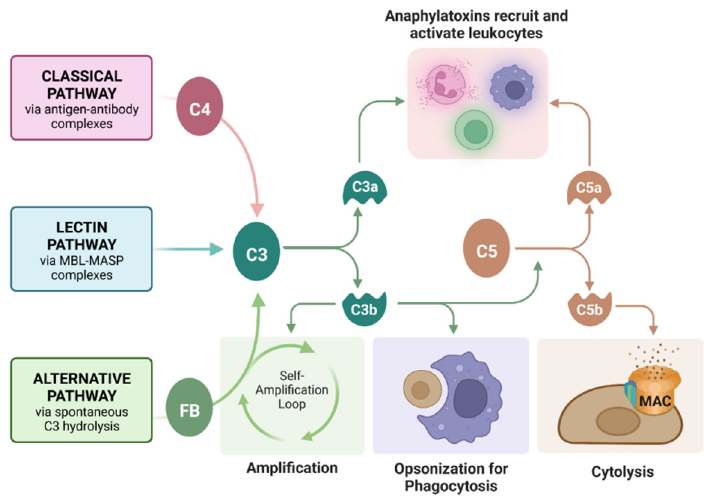
Figure 1. Roles of the complement cascade in graft rejection. Complement can be activated by antibody-bound-antigens recruiting C4 (classical pathway), mannose-binding lectin (MBL)-MBL serine protease (MASP) complexes (lectin pathway, not commonly implemented in graft rejection), or spontaneously by C3 hydrolysis and Factor B (FB) recruitment (alternative pathway). All three pathways converge on the cleavage of C3, which feeds back into the alternative pathway for amplification, opsonizes the grafted cells for phagocytosis, or cleaves C5 to form the membrane attack complex (MAC, C5bC6C7C8C9), causing cell lysis. Anaphylatoxins C3a and C5a recruit and activate leukocytes, inducing inflammation. Figure created with Bio Render.com (accessed on 29 November 2022).